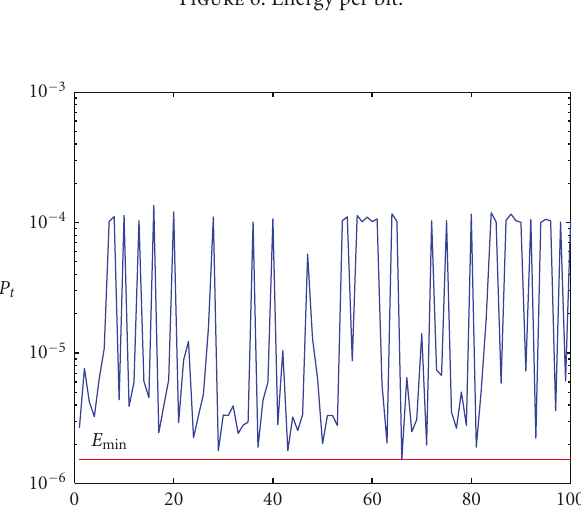
Figure 6: Energy per bit.